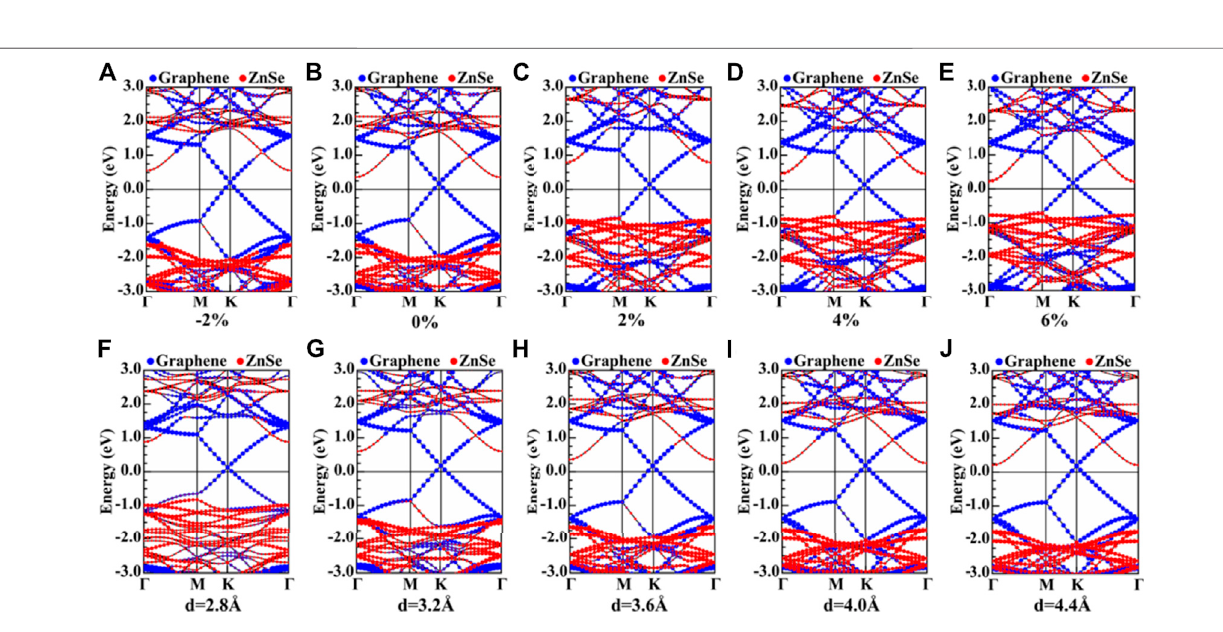
Frontiers in Chemistry |